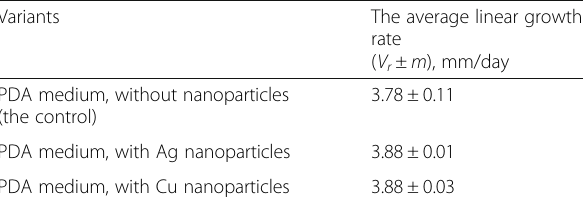
Table 1 The linear growth rate of P. herpotrichoides mycelium on PDA with the addition of silver and copper metal nanoparticles Variants